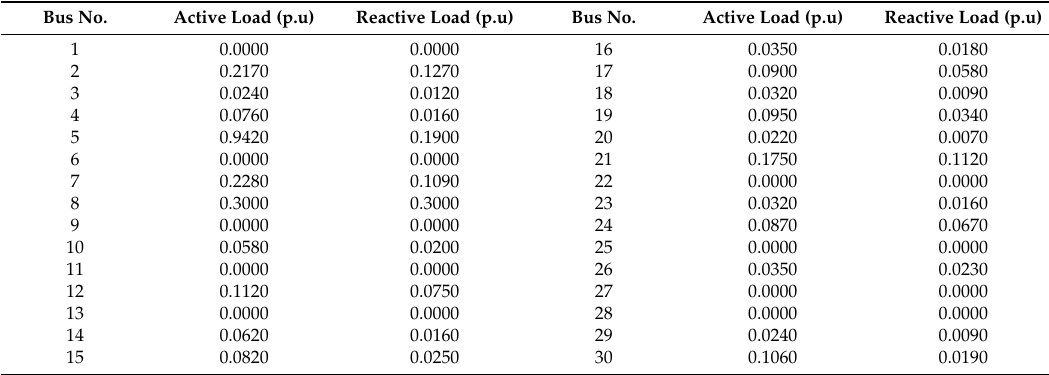
Table A2. Load data of IEEE 30-bus